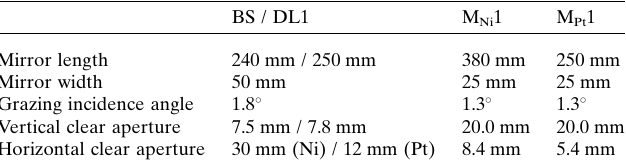
Table 1 Nominal apertures of the mirrors of the SDU for the incoming beam. The clear aperture takes into account the existence of a 5 mm not specified rim at the edges of the optical surfaces. BS / DL1 M Ni 1 M Pt 1